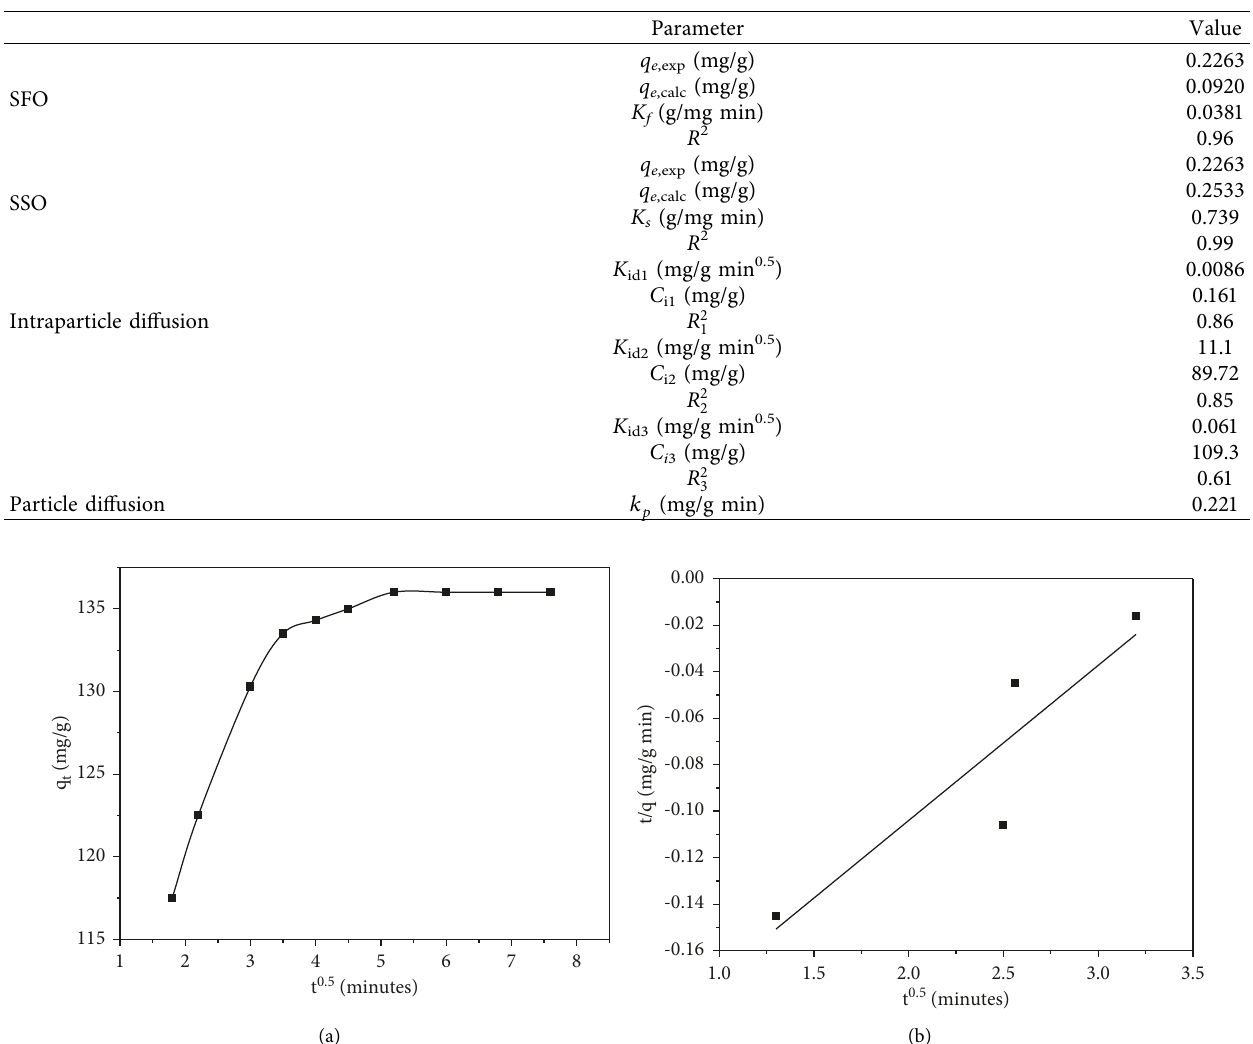
Figure 12: Pseudo-first-order (a) and pseudo-second-order (b) kinetics models of fluoride adsorption onto GO. Table 3: The kinetics parameters for the adsorption of fluoride ions by GO.